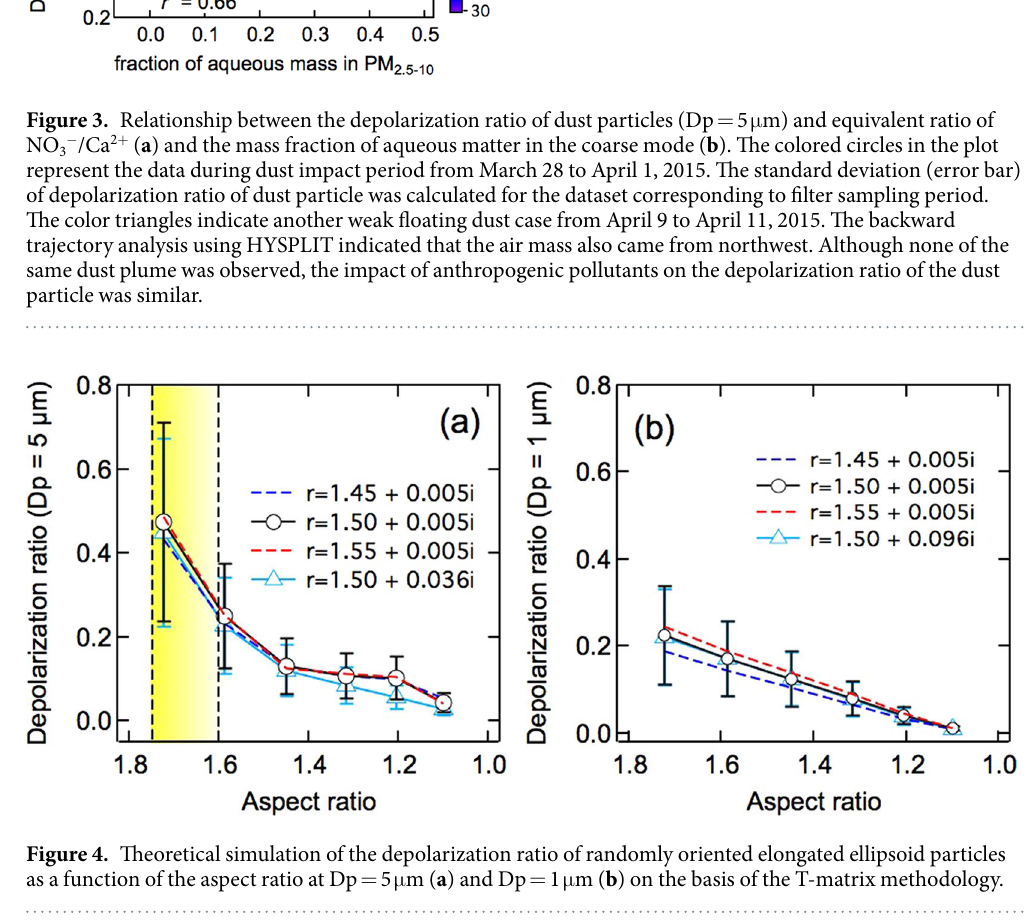
was worthy noting that mass concentration of cNO 3 − was much larger than cSO 42 − in dust plume, with a cNO 3 − / cSO 42 − mass ratio of 1.5–2.5, much higher than the value (0.16–0.5) reported ten years ago during the polluted dust period in Beijing 27 . It demonstrated that NO x has exceeded SO 2 as the most important pollutant in Beijing area, in accordance with bottom-up emission inventory estimation 35 . Consequently, more direct absorption of reactive HNO 3 on the alkaline surface of dust particles becomes important to form strong hydrophilic com- pounds such as Ca(NO 3 ) 2 29, 36 , the latter of which absorb water vapors at relative humidity (RH) above 10% 30 , and apparently will affect to serve as cloud condensation nucleus (CCN). Another important point, mineral dust and organic aerosols have traditionally been studied separately, how- ever, more and more observations with a variety of means pointed out that adsorption of short-chain oxygen- ated hydrocarbons and low-vapor-pressure organic species (i.e. carboxylic acid) onto the dust surface cannot be overlooked 37–39 . For instance, shipboard aerosol time-of-flight mass spectrometer (ATOFMS) measurement of Asian aerosol outflow found that oxalic and malonic acids predominantly internally mixed with mineral dust, as a result of photochemical oxidation of volatile organic and diacids partitioning 40 . Quantitative analysis of